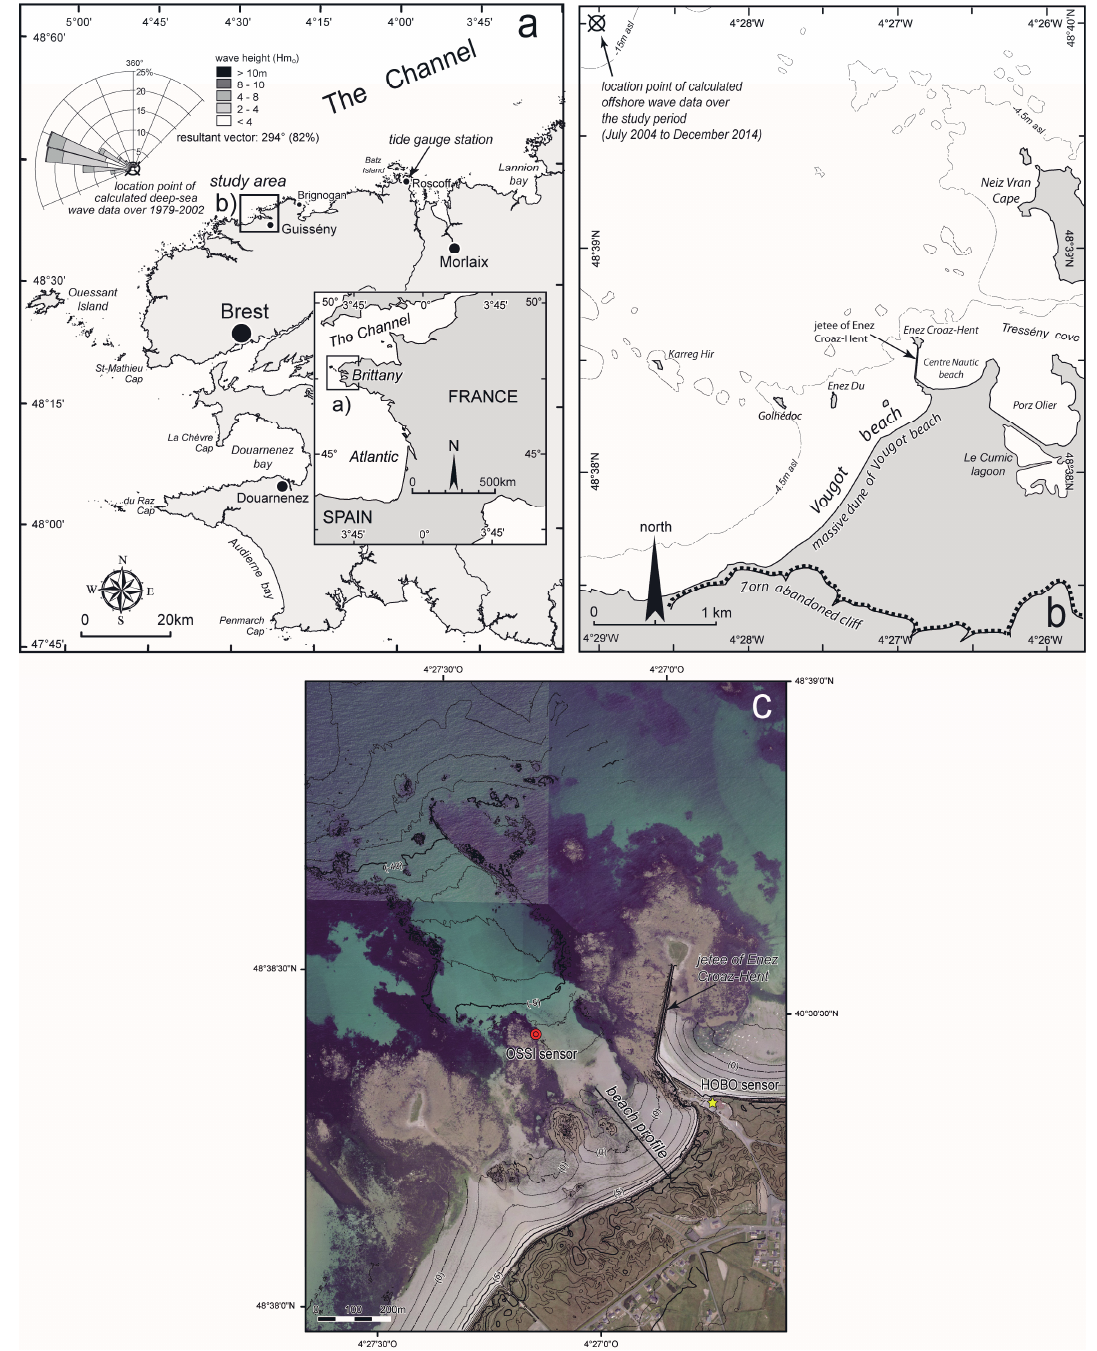
Figure 2. Location map. Regional setting and Roscoff tidal gauge station ( a ); local setting and location point where offshore wave data ( H m0 and T m0 , –1 ) were calculated using (WW3) modeling ( b ); and aerial photography of Vougot beach showing the beach/dune profile location and both wave/water level and atmospheric pressure sensors ( c